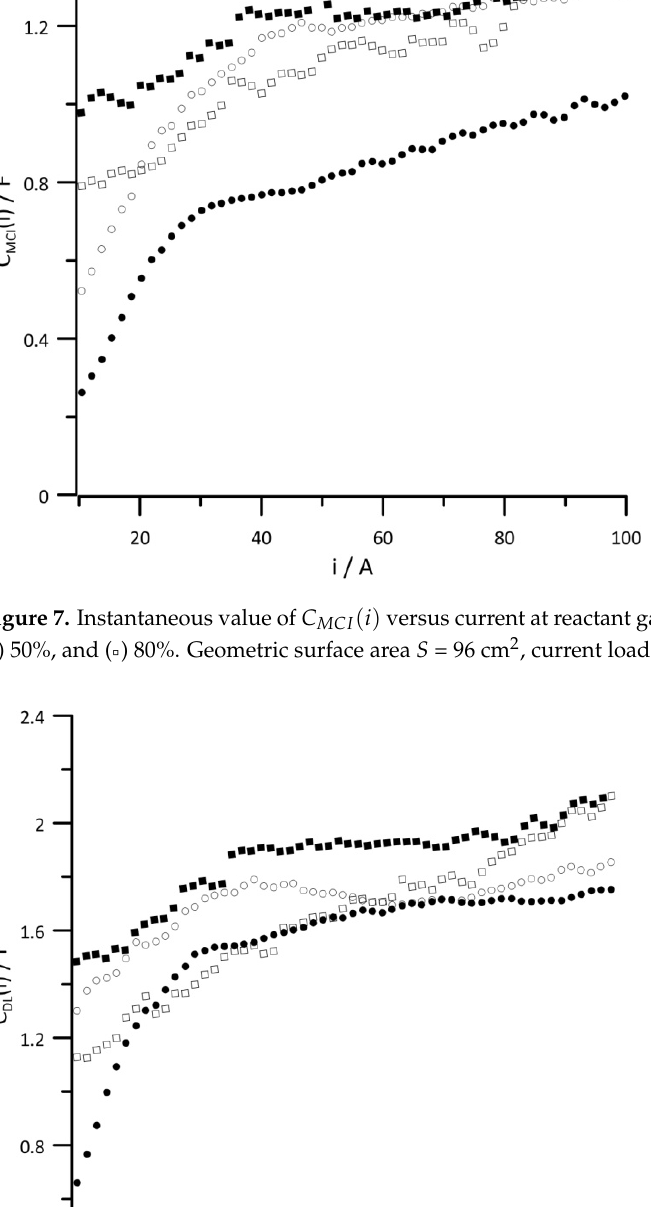
Figure 3. Impedance spectra of the PEMFC middle cell obtained in galvanodynamic mode. Geometric surface area S = 96 cm 2 , current load change rate d i /d t = 40 mA s − 1 , and measurement frequencies range from 5–1123 Hz. RH of reactant gases ( A ) 10%, ( B ) 30%, ( C ) 50%, and ( D ) 80%. The I - V characteristics recorded for supplied reagents with a humidity of 80% devi- ated from the other characteristics in the entire current range. Based on this simple anal- ysis, it can be concluded that a humidity of 80% is too high and adversely affects the fuel cell operation over the entire current range. Analyzing the voltage changes of the re-